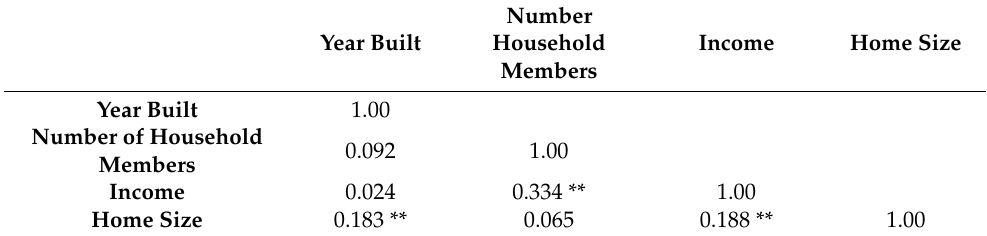
Table 7. Correlation analysis—Marine Climate (Spearman’s ρ ).